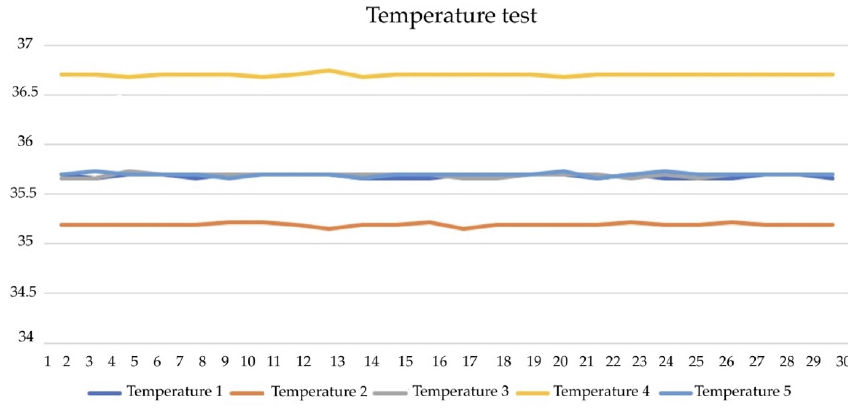
Figure 14. Temperature test.